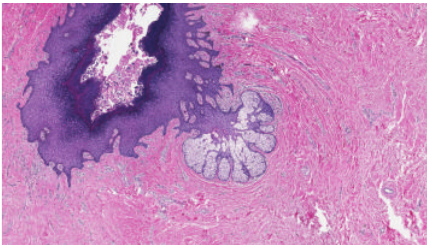
Figure 5: Low power pathology slide (features of accessory nipple including increase in pilosebaceous units and smooth muscle bundles).